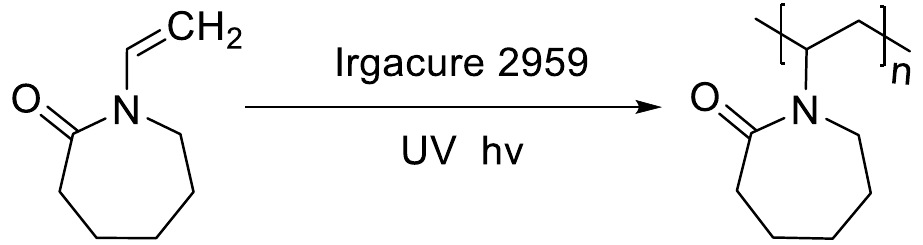
Figure 1. Scheme of photopolymerisation of N-vinylcaprolactam using Irgacure 2959 to yield poly (N-vinylcaprolactam).